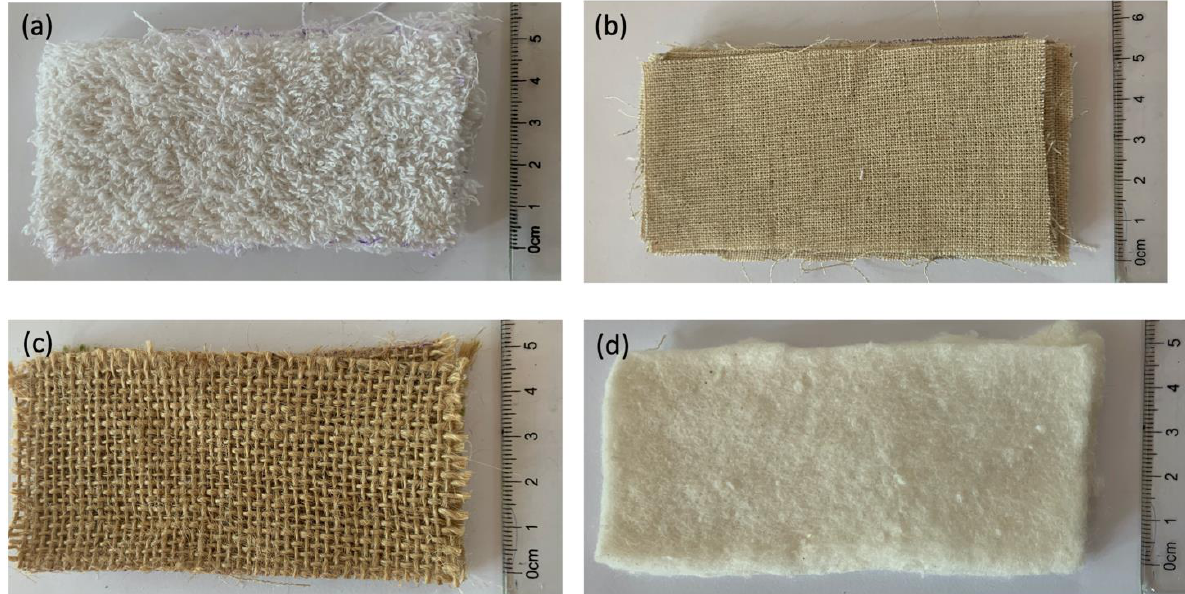
Figure 1. Optical photograph of the biodegradable materials used in the present study before absorption of gelatine solution; ( a )—100% cotton terry cloth, ( b )—100% linen cloth, ( c )—100% hemp cloth, ( d )—100% bamboo wadding;